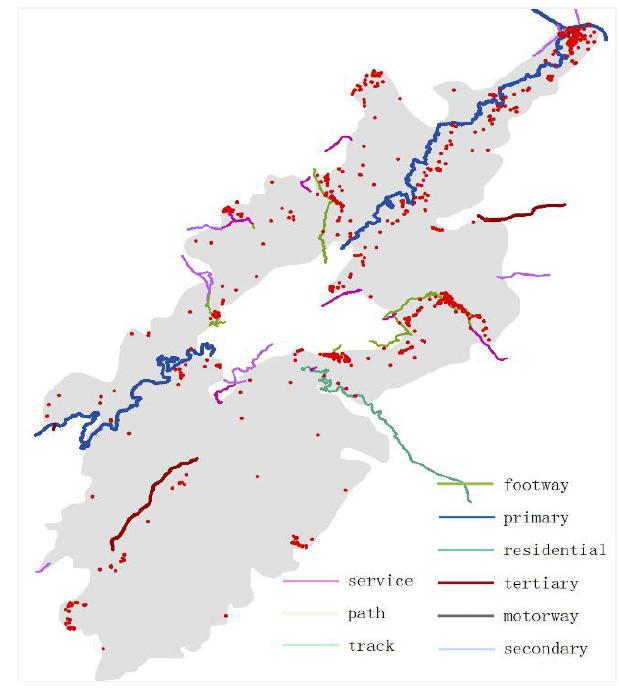
Figure 7 Distribution of microblogging around road with different type.